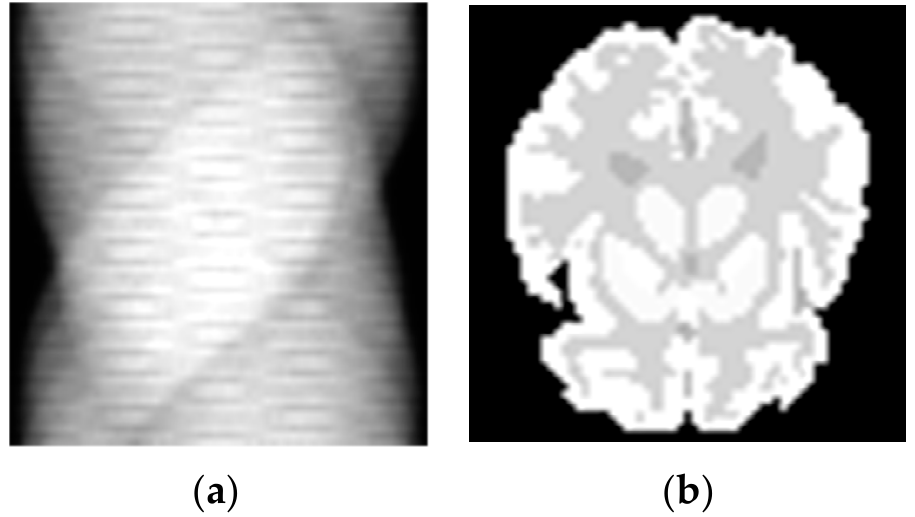
Figure 3. The sinogram image and the corresponding activate image. There is not a simple pixel-to- pixel relationship between ( a , b ). Each pixel of sinogram has its own physical meaning. The abscissa position of the pixel refers to the distance between line-of-response (LOR) and the center of the detector. The ordinate position of the pixel refers to the angle between LOR and the standard sur- face. The value of the pixel refers to the number of coincidence events recorded by the detector in the corresponding at this position.